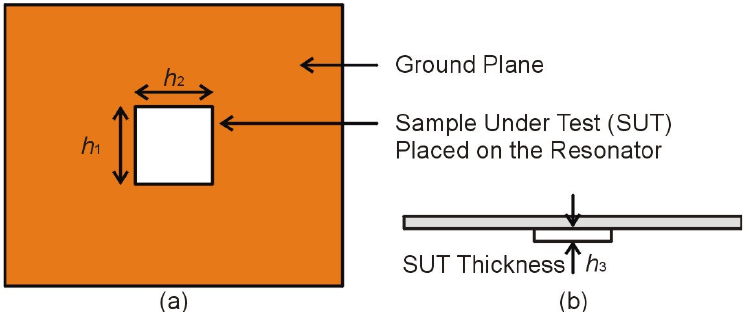
Figure 5. The sensor’s ground plane contains the sample under test (SUT) which interacts with the electromagnetic fields created by the microstrip transmission line and radiated by the resonator, ( a ) Top View ( b ) Front View.